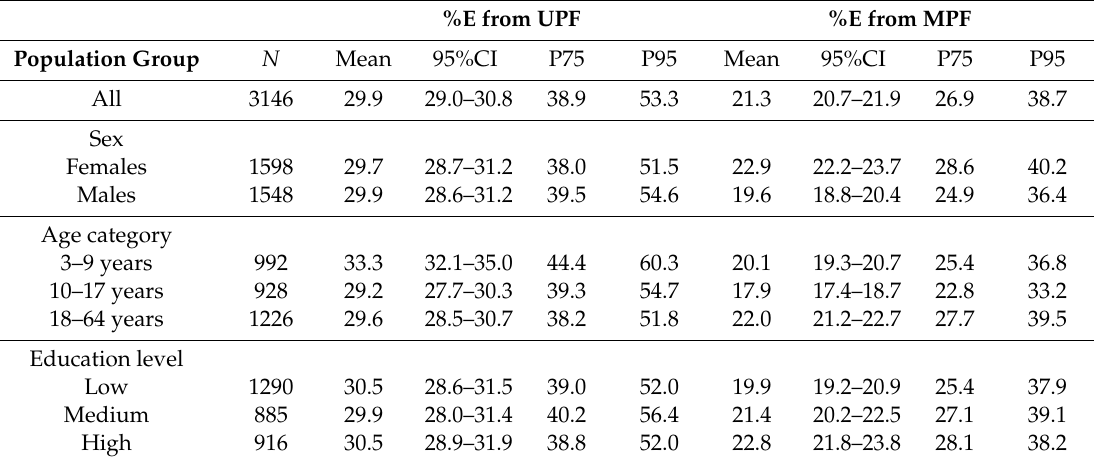
Table A1. Mean percentage of daily energy intake from unprocessed / minimally processed foods (MPF)